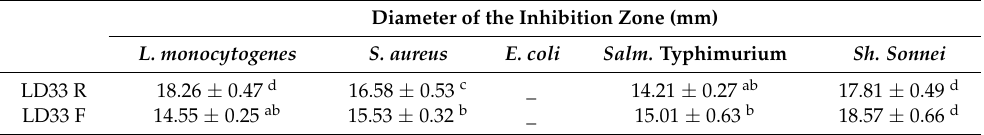
Table 1. Antibacterial activity of the strain E. faecalis LD33 on the selected pathogenic bacteria. Diameter of the Inhibition Zone